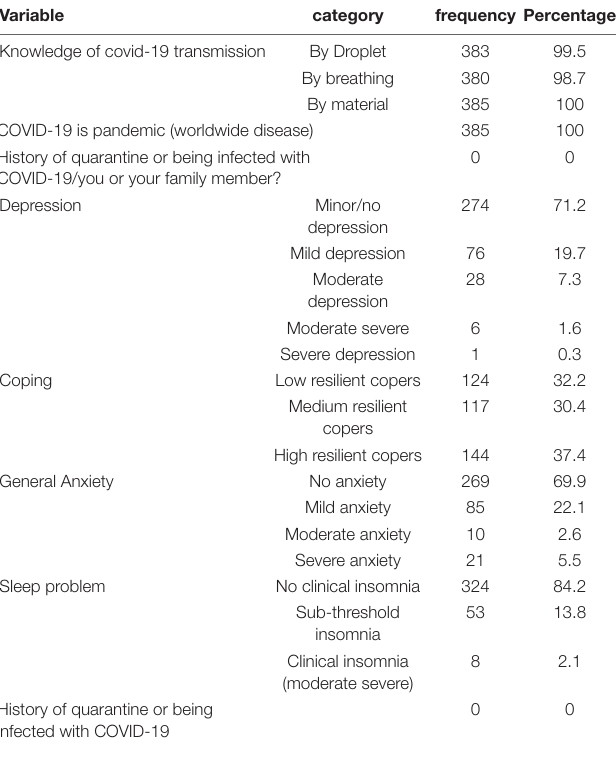
TABLE 2 | Prevalence report of participants on knowledge about COVID-19, depression, general anxiety, coping status, and sleep